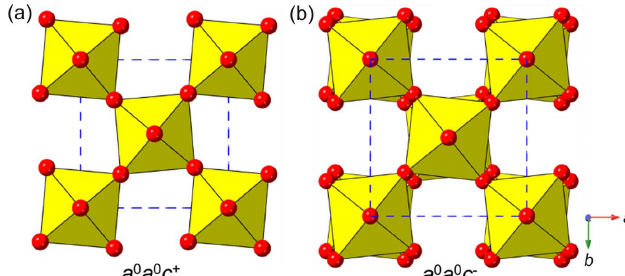
Figure 1 Octahedral framework of the ideal cubic perovskite showing the structure with ( a ) in-phase and ( b ) out-of-phase octahedral tilting, described by Glazer tilt notations a 0 a 0 c + and a 0 a 0 c (cid:2) , respectively. B -centred octahedra and X atoms are shown in yellow and red,